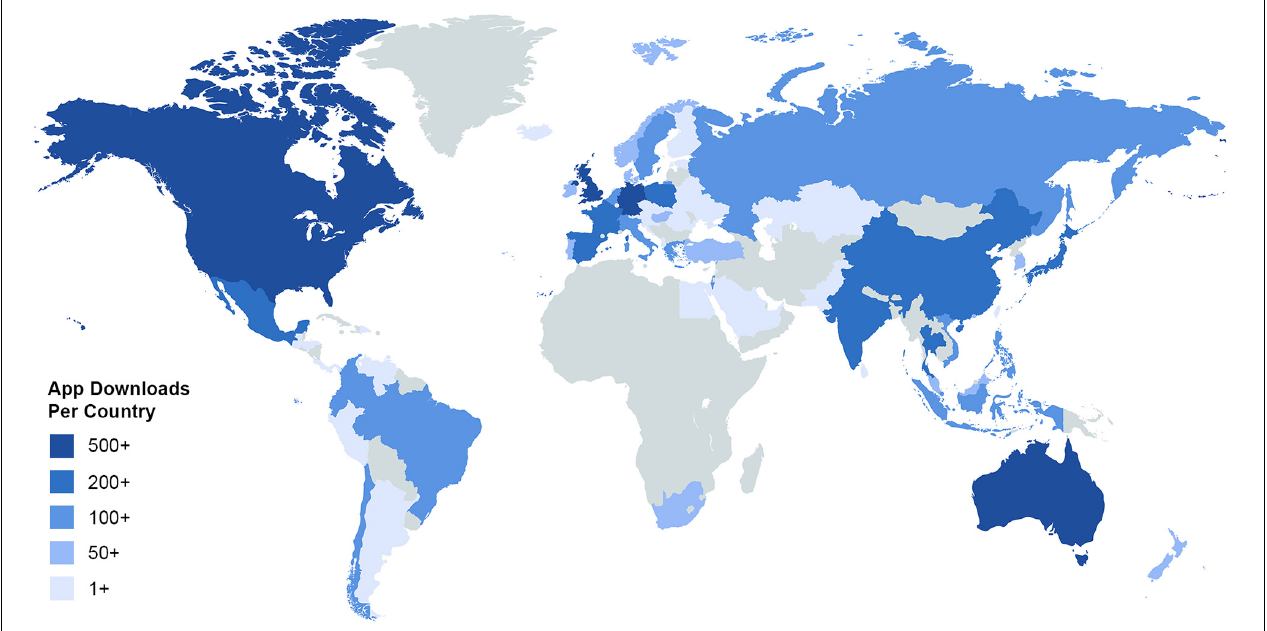
FIGURE 6 | NeMO-Net download map. Location data is opt-in, causing known downloads to be lower than actual downloads. In the 7 months since release, NeMO-Net has been downloaded in at least 73 countries, reached over 300 million people, received a 4.9-star rating on the App Store, reached #3 in the App Store family games category, generated over 76K player classification maps and over 62K reviews of other players’ classification maps.